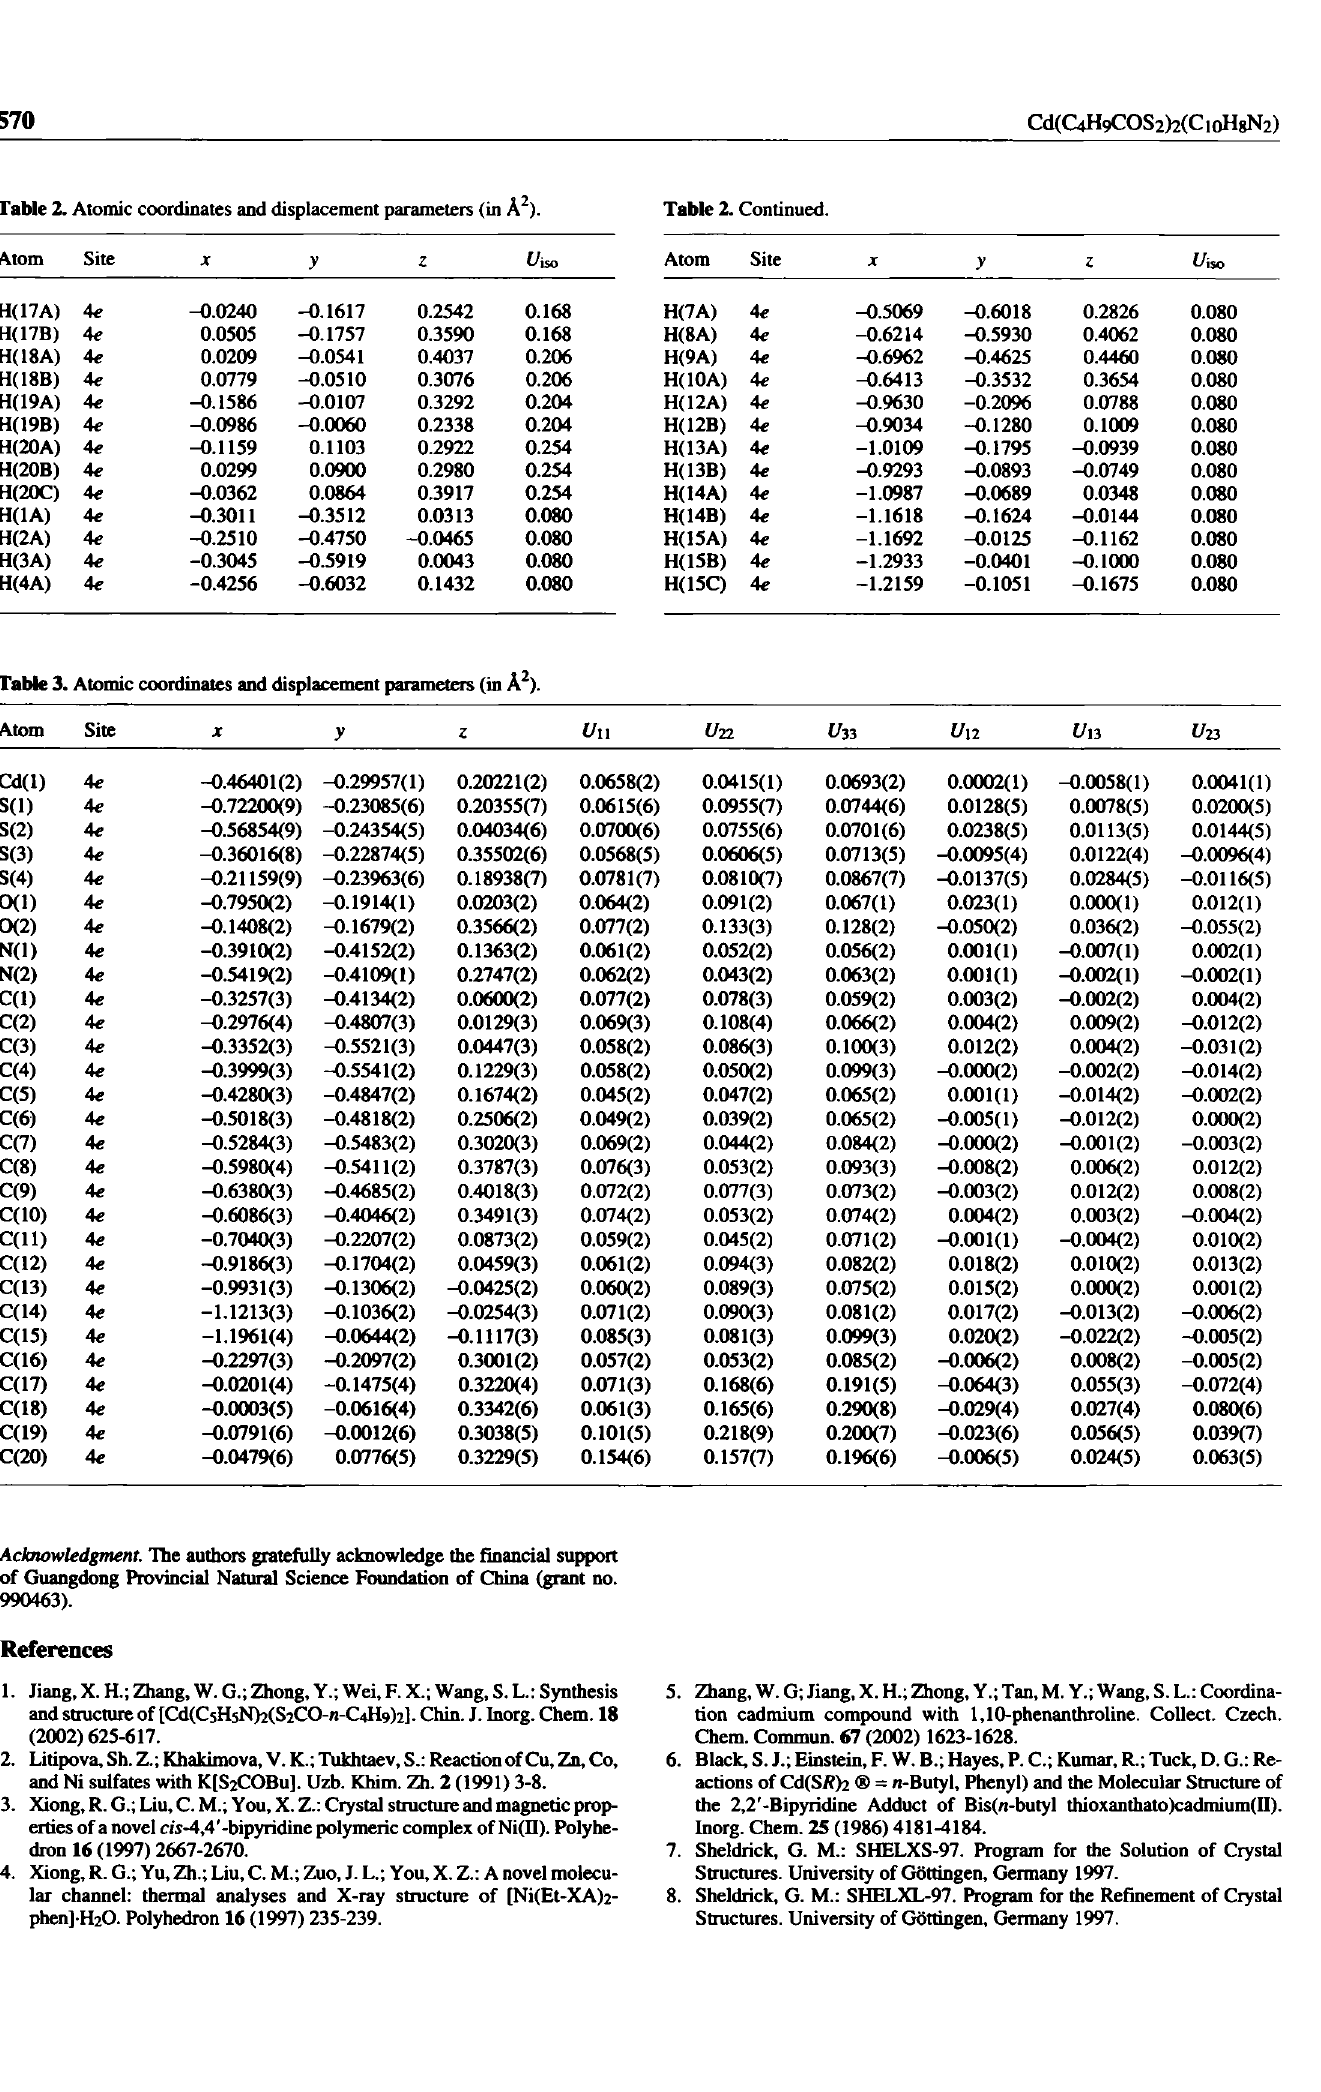
Table 3. Atomic coordinates and displacement parameters (in A 2